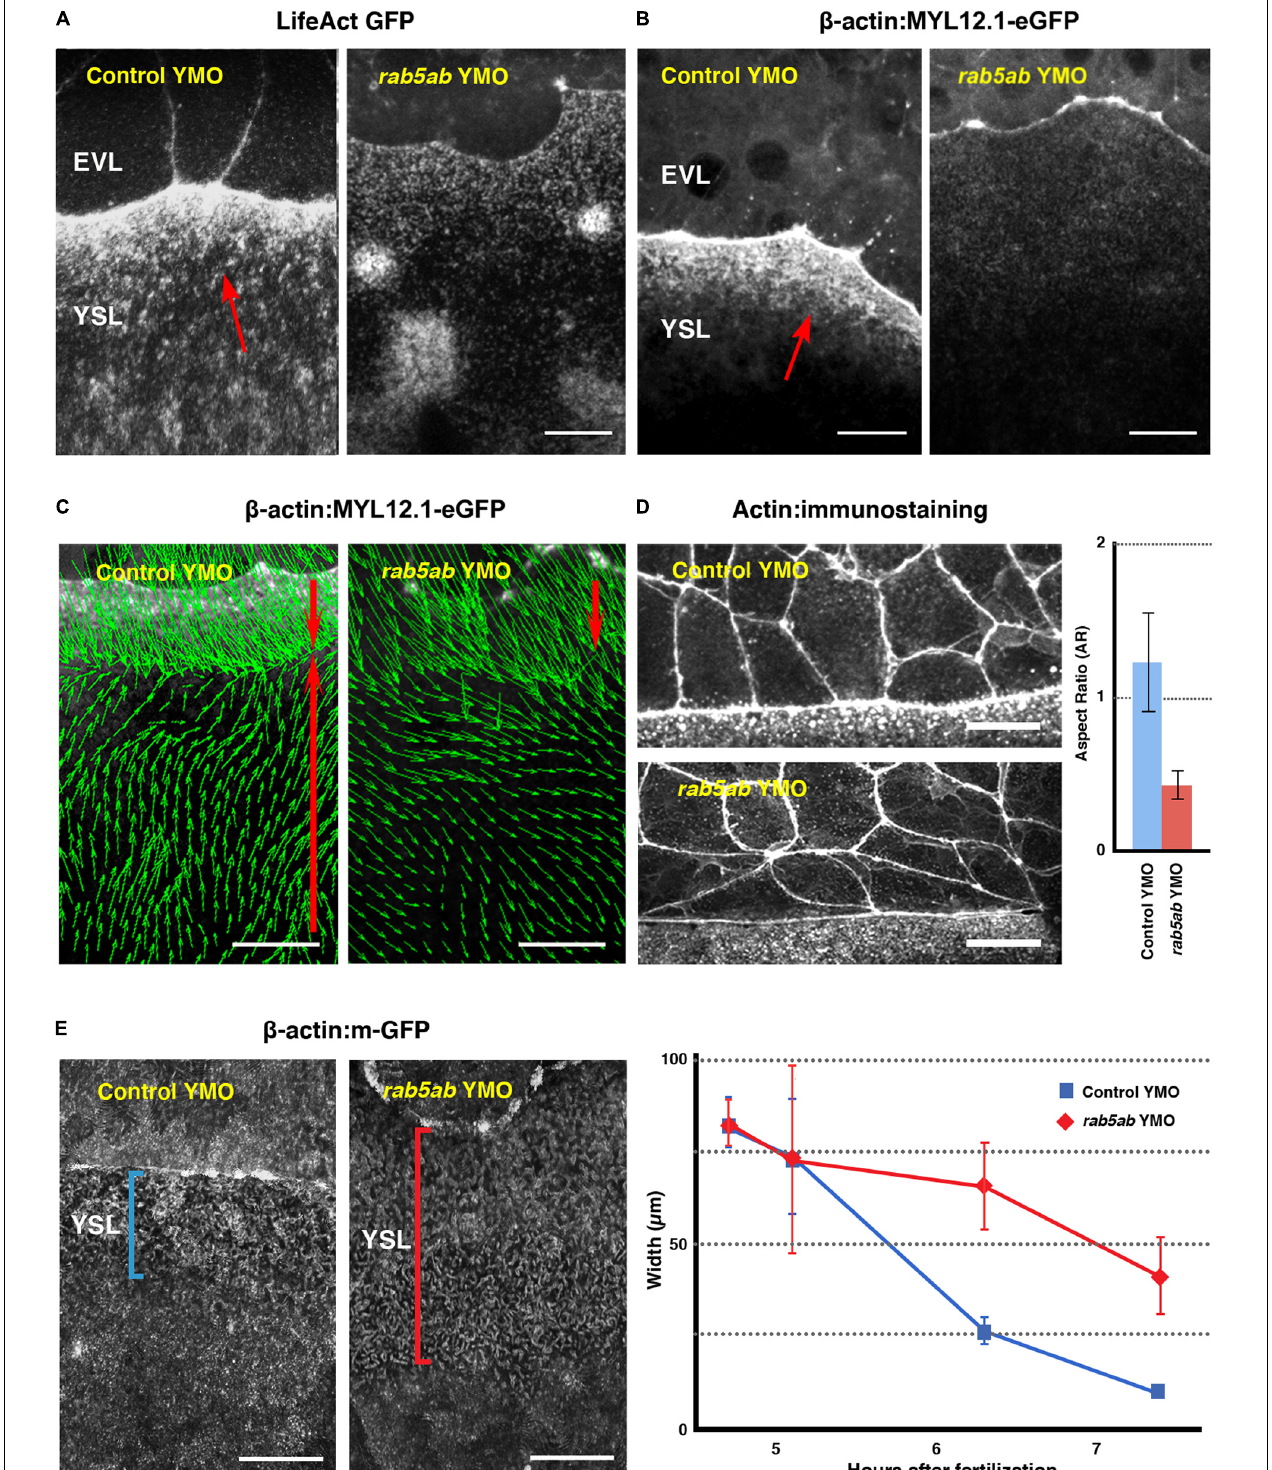
FIGURE 3 | Cytoskeleton dynamics and EVL leading cells shapes are affected by rab5ab depletion. (A) Actin fails to accumulate at the E-YSL in rab5ab YMOs versus controls (Control YMO). Time-lapse snapshots of two LifeAct GFP injected sibling embryos. (B) Myosin fails to accumulate at the E-YSL of rab5ab YMOs versus controls (Control YMO). Time-lapse snapshots of two Myosin-GFP transgenic [Tg ( β - actin:MYL12.1-eGFP )] sibling embryos. Note the delay in the progression of